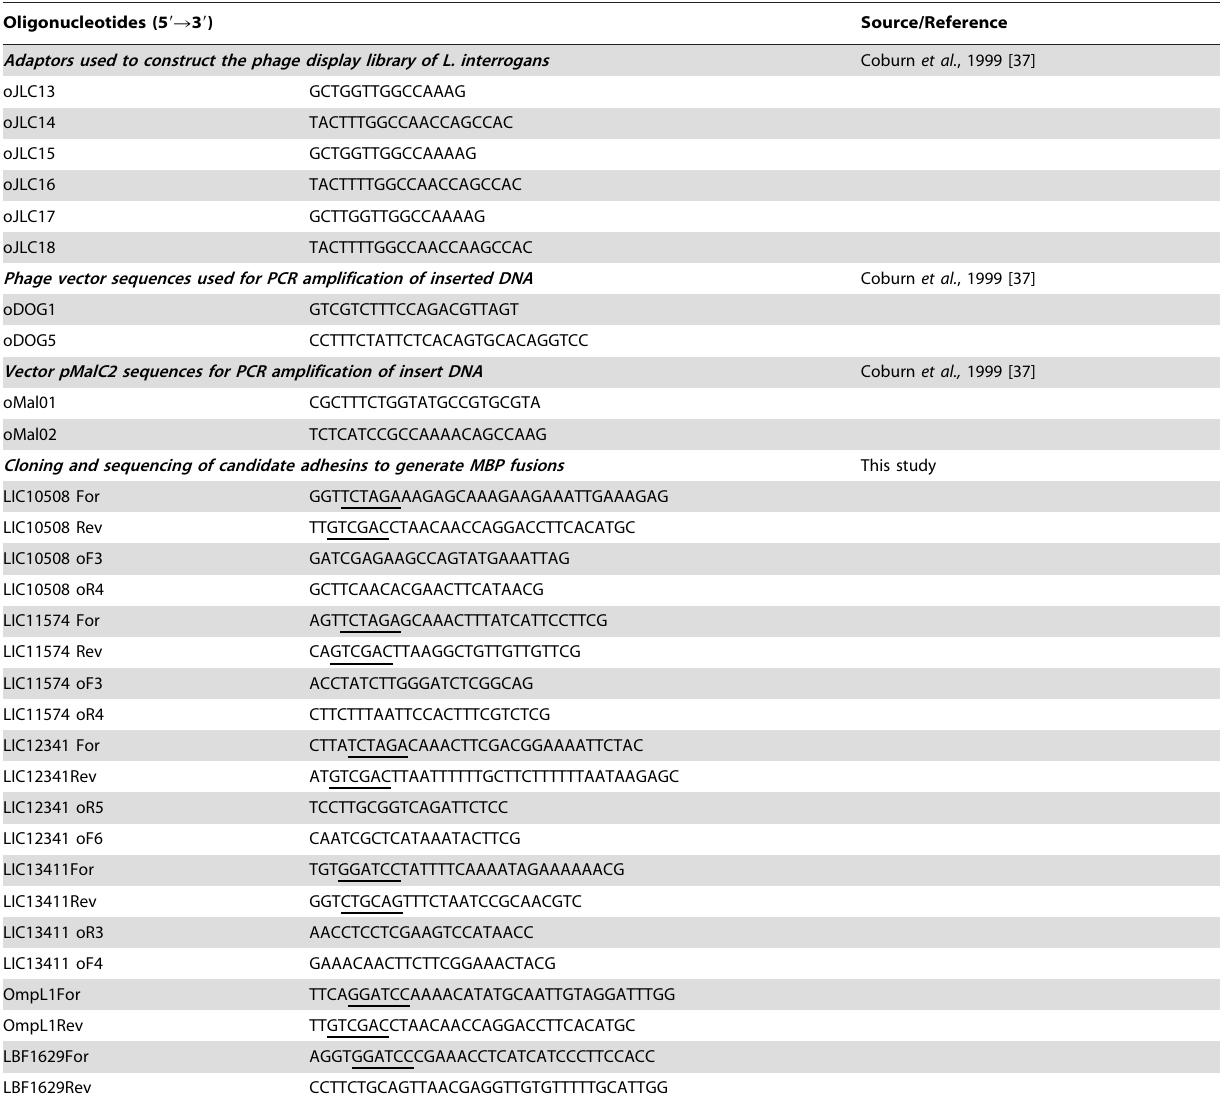
Table 1. Oligonucleotides used in this